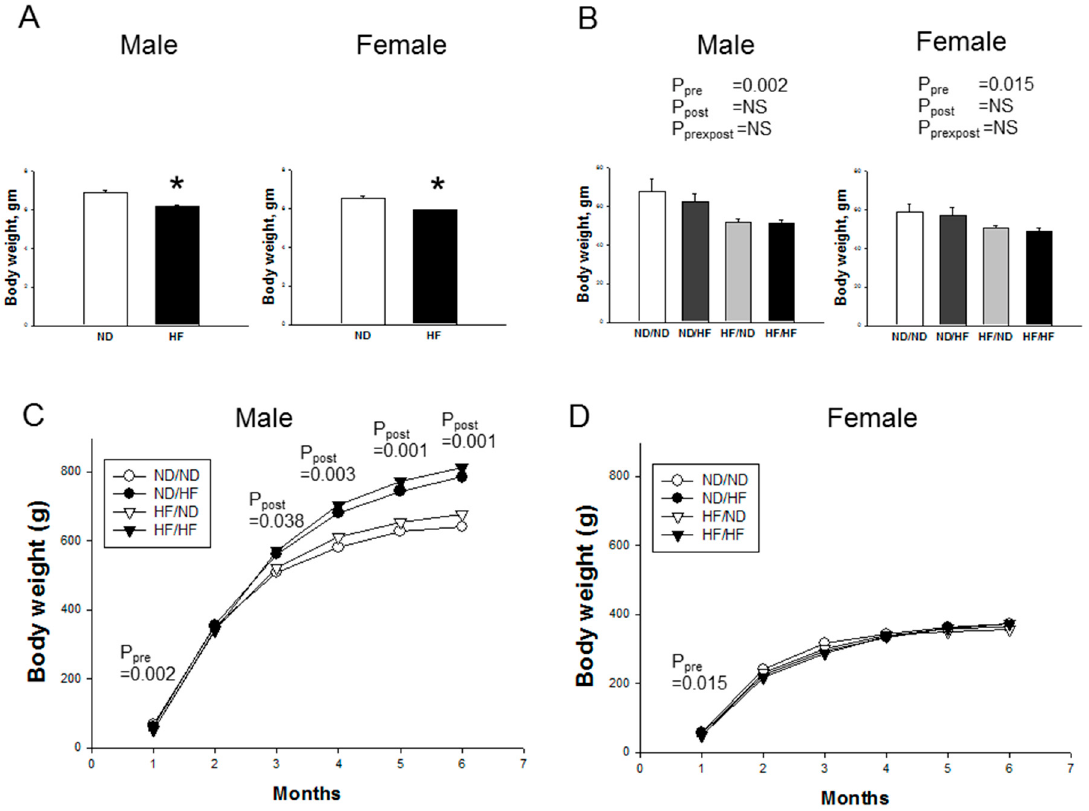
Figure 1. Effects of maternal and postnatal high-fat (HF) diet on bodyweight in: ( A ) neonates; ( B ) male and female offspring at one month of age; and ( C ) male offspring; and ( D ) female offspring from one to six months. * p < 0.05 vs. HF; Pre × Post, interaction of pre × post; NS, not significant; N (pups/L) = 5-7/3 per group.